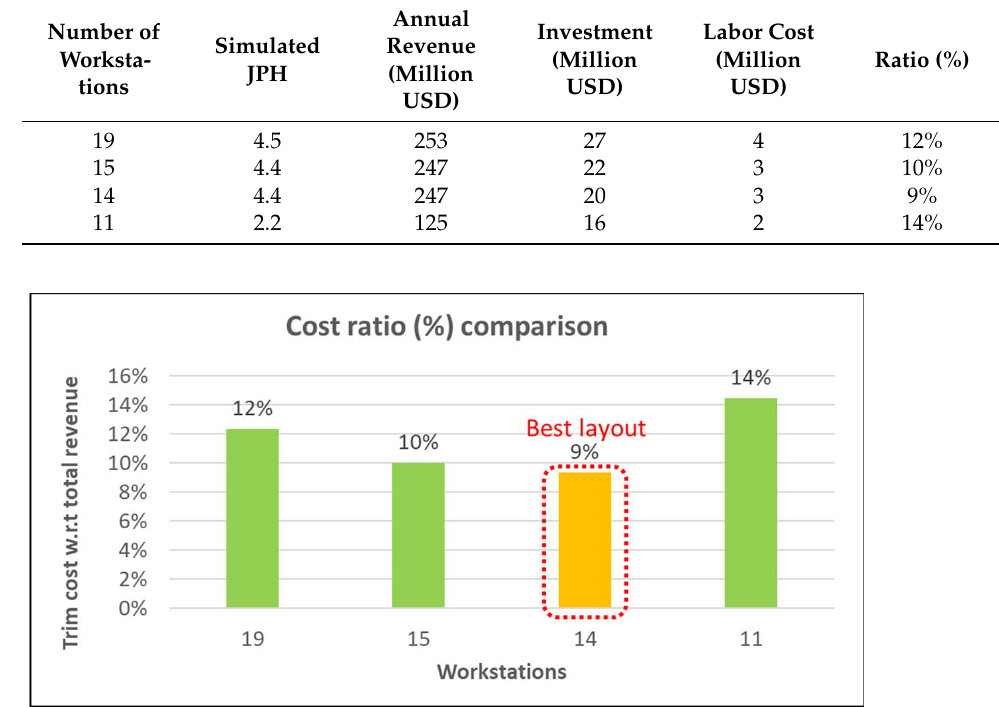
Figure 11. Comparison of different layouts in terms of cost ratio (%) of trim area w.r.t. total revenue.